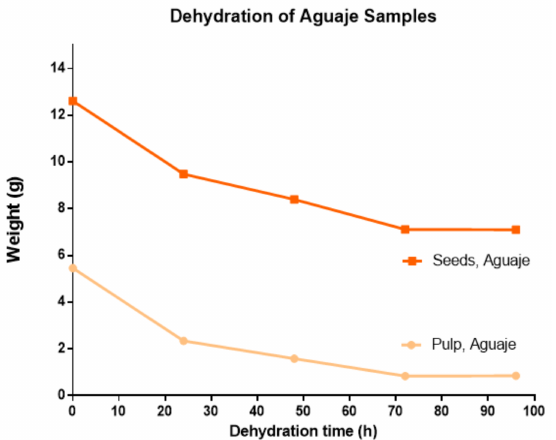
Figure 2. Dehydration curve for M. flexuosa , pulp and seeds at a constant 50 ◦ C from 0 to 96 h.